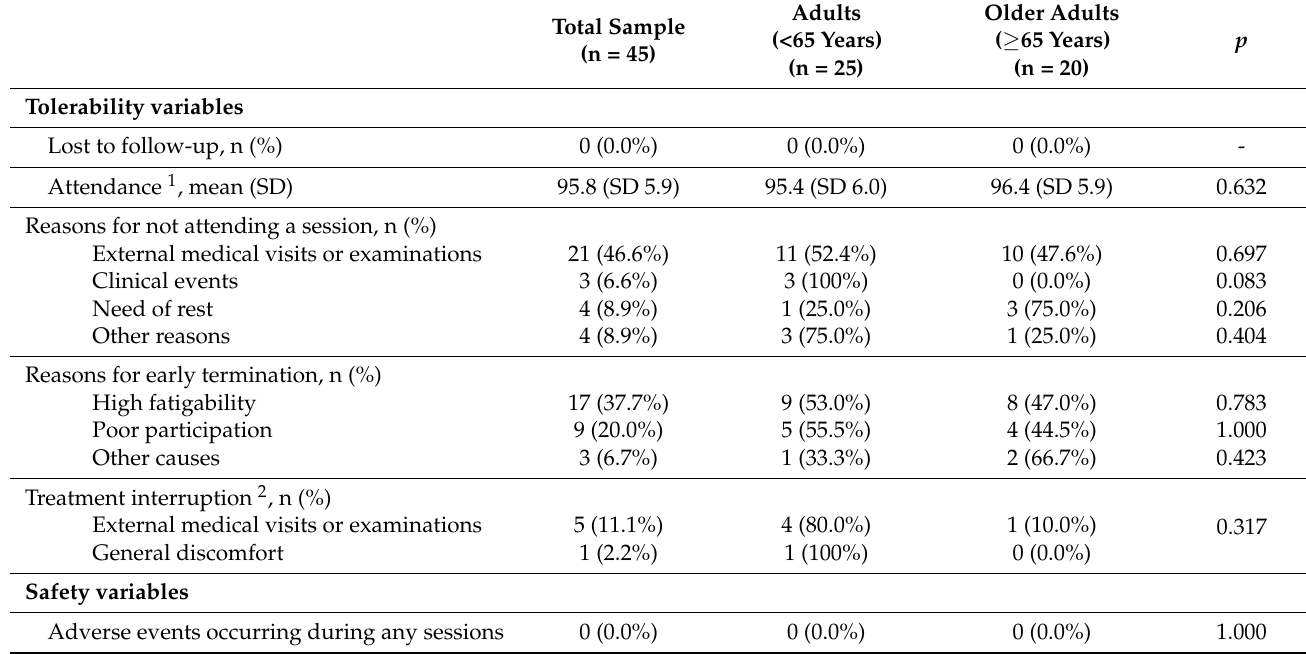
Table 5. Tolerability and safety